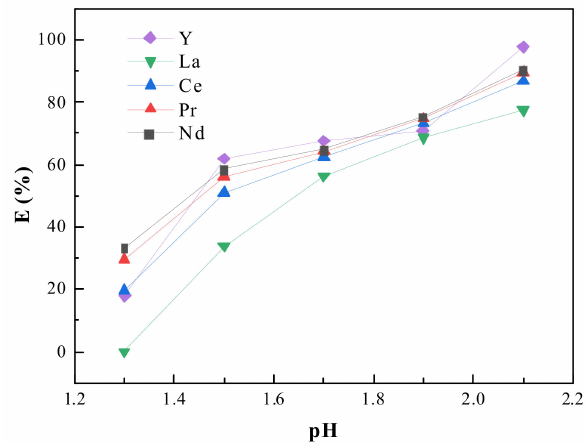
Figure 3. Effect of solution pH on the extraction of